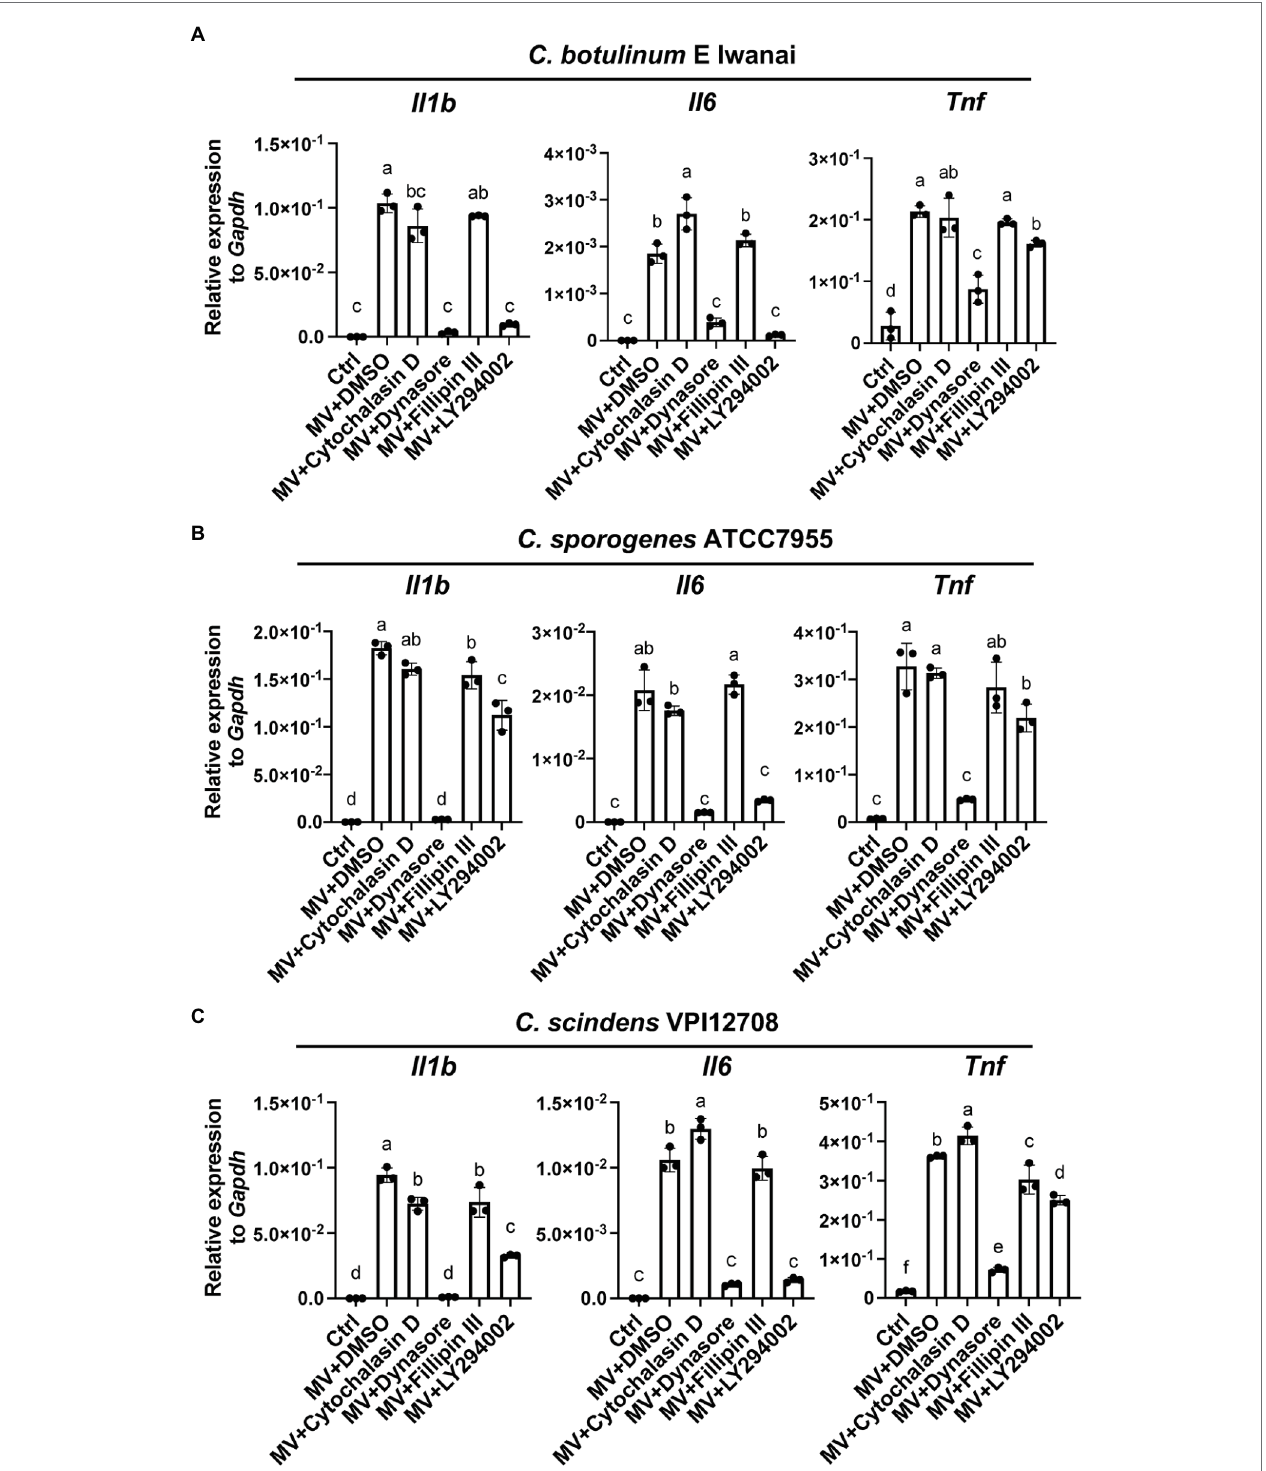
FIGURE 6 | Dynamin-dependent endocytosis and PI3K activity are responsible for the induction of cytokine expression by clostridial MVs in RAW264.7 cells. Cells were pre-treated with 20 μ M cytochalasin D, 80 μ M dynasore, 20 μ g/ml filipin III, or 10 μ M LY294002 for 2 h. Cells were then treated with 10 μ g/ml MVs derived from (A) C. botulinum type E Iwanai, (B) C. sporogenes ATCC7955, or (C) C. scindens VPI12708, with inhibitors for 6 h. Gene expression levels were measured using a RT-qPCR analysis. Ctrl, control. Means that do not share a letter are significantly different ( p < 0.05). Error bars indicate SD. n = 3, a one-way ANOVA with Tukey’s multiple comparisons post hoc test. Data are representative of two independent